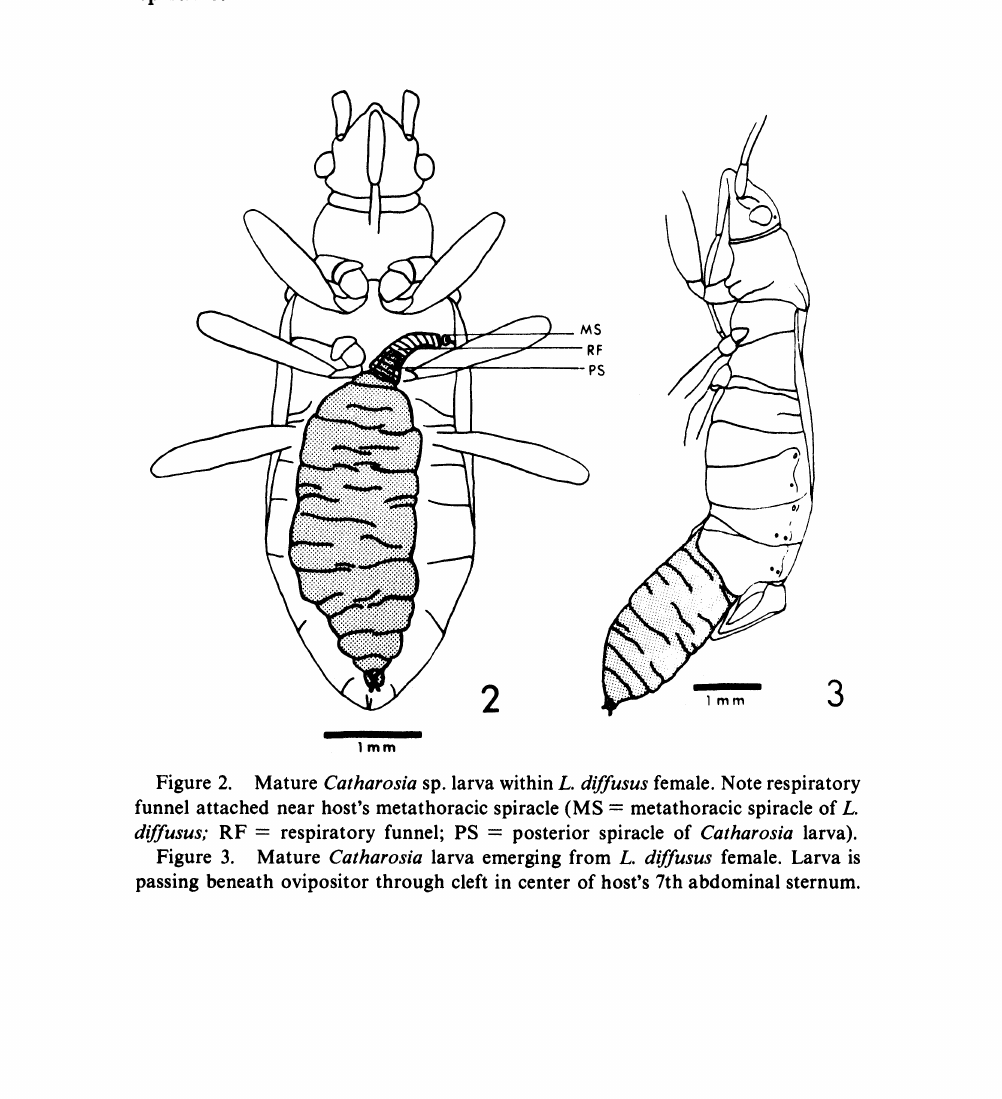
Figure 2. Mature Catharosia sp. larva within L. diffusus female. Note respiratory funnel attached near host’s metathoracic spiracle (MS metathoracic spiracle of L. diffusus; RF respiratory funnel;